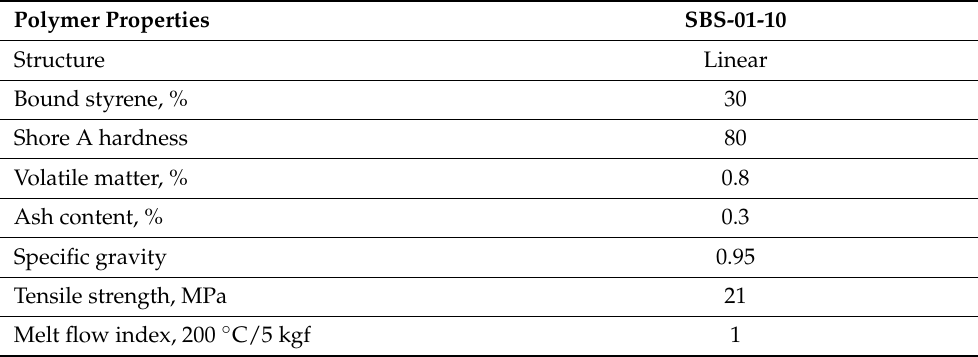
Table 3. The composition of SBS polymer.